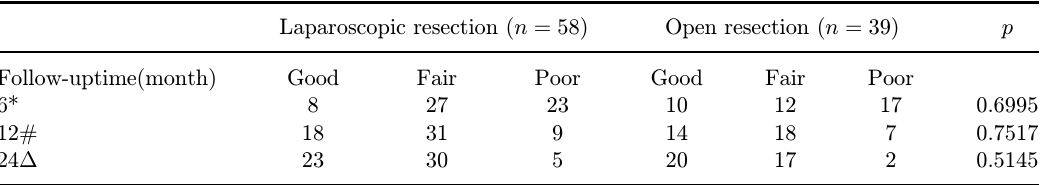
Table 3. Defecation function of patients